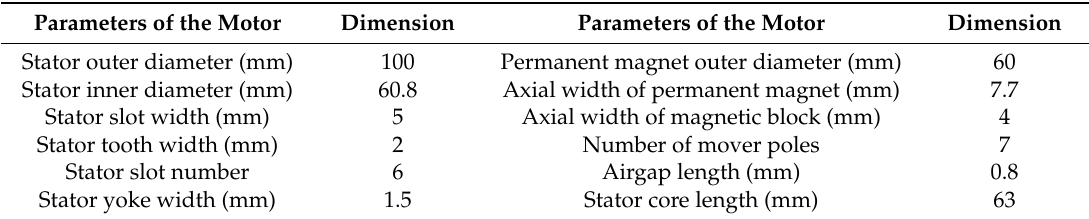
Table 3. Structure parameters of linear